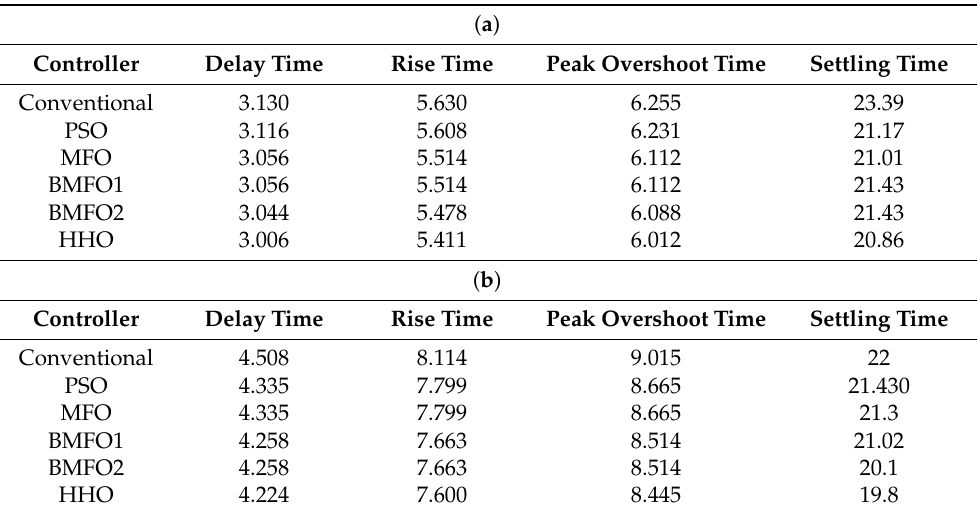
Table 19. ( a ). Graph analysis of GENCOs to DISCOs generation response of Area1 with various controllers under contract violation case. ( b ). Graph analysis of DISCOs to GENCOs generation response of Area1 with various controllers under contract violation case.